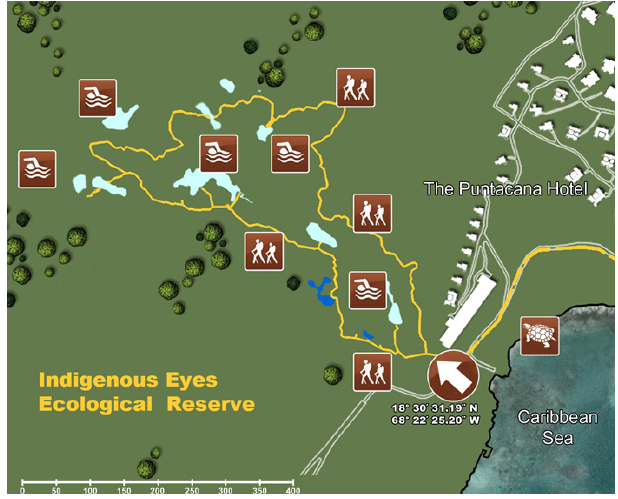
Fig. 3 . Map of Indigenous Eyes Ecological Reserve. (©